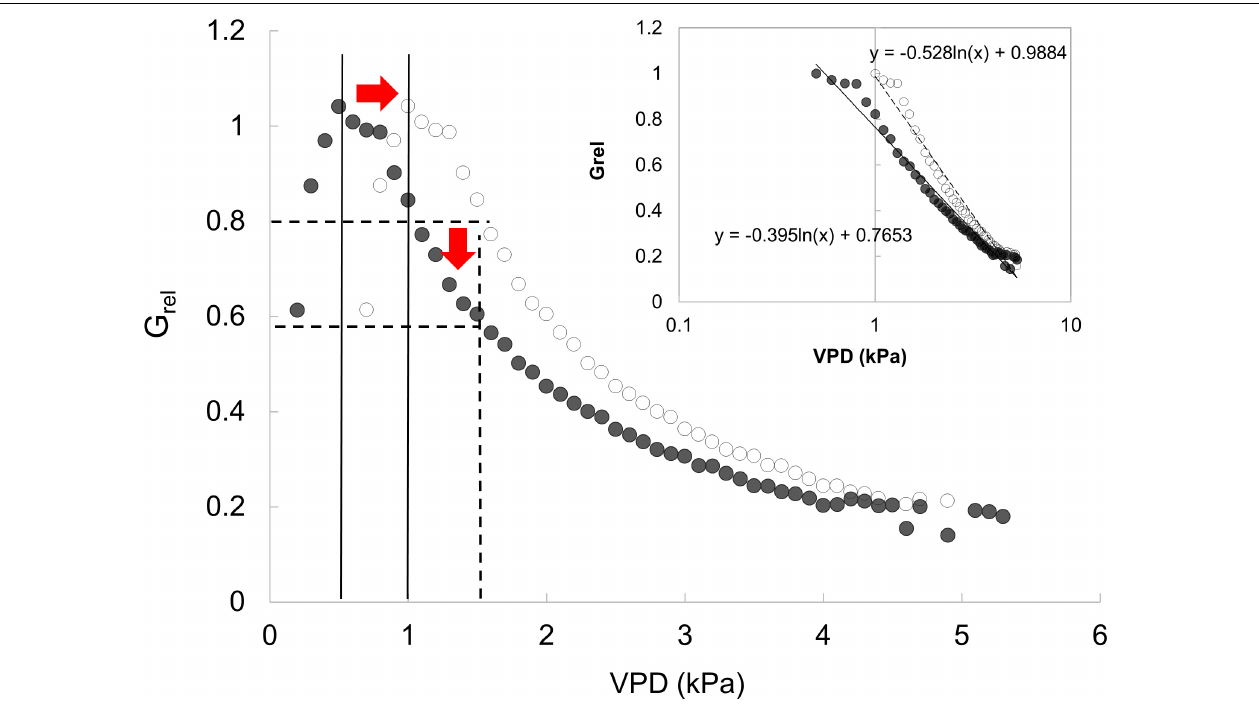
FIGURE 6 | Simulation of the response of G rel to VPD with G rel calculated with two different maximum G . Inset presents the same data with x-axis log transformation. Black markers show the max G rel at 0.5 kPa, the 0.8 × G rel at 1 kPa and a slope of − 0.39. White markers show max G rel at 1 kPa, thus 0.8 × G rel shifts toward the 1.5 kPa and the slope increases to about